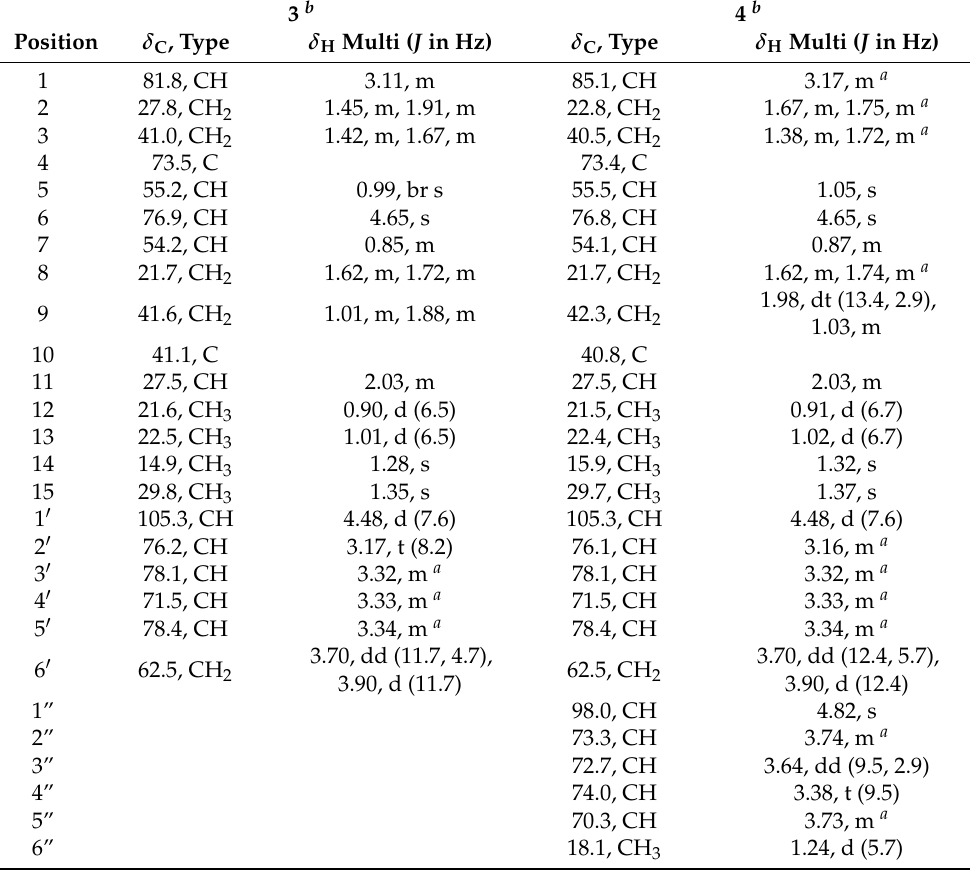
Table 2. 1 H and 13 C NMR data (methanol- d 4 ) for compounds 3 and 4 . 3 b 4